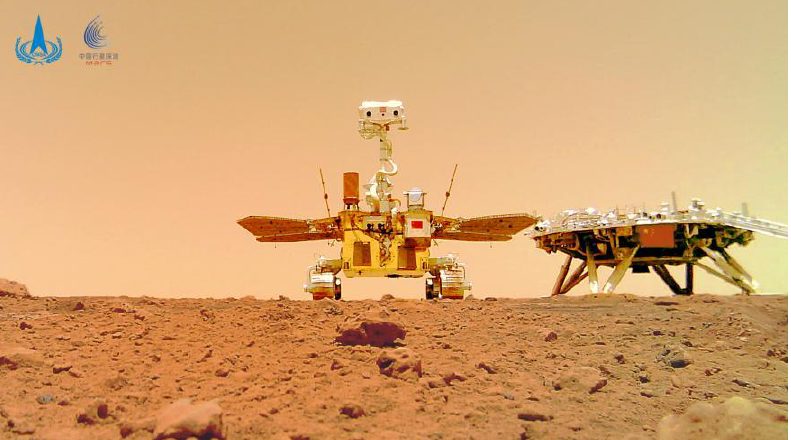
Figure 1. The image of Zhurong and landing platform on Mars; it was released by the China National Space Administration (CNSA).